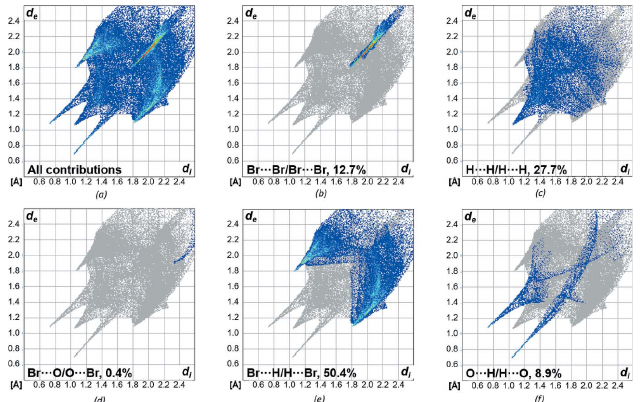
Figure 5 Two-dimensional fingerprint plots for bromomethylalcohol 1 showing close contacts for ( a ) all contributions in the crystal and those delineated into ( b ) Br (cid:3)(cid:3)(cid:3) Br, ( c ) H (cid:3)(cid:3)(cid:3) H, ( d ) Br (cid:3)(cid:3)(cid:3) O/O (cid:3)(cid:3)(cid:3) Br, ( e ) Br (cid:3)(cid:3)(cid:3) H/H (cid:3)(cid:3)(cid:3) Br and ( f ) O (cid:3)(cid:3)(cid:3) H/H (cid:3)(cid:3)(cid:3) O-interactions.